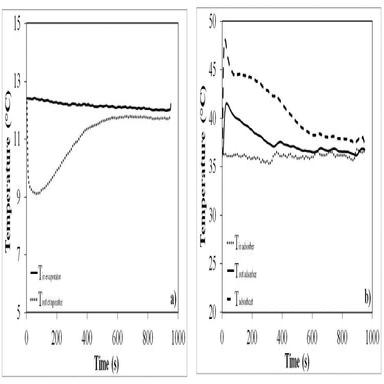
(a) Temperatures in the evaporator; (b) Adsorber and adsorbent temperature during discharging phase.